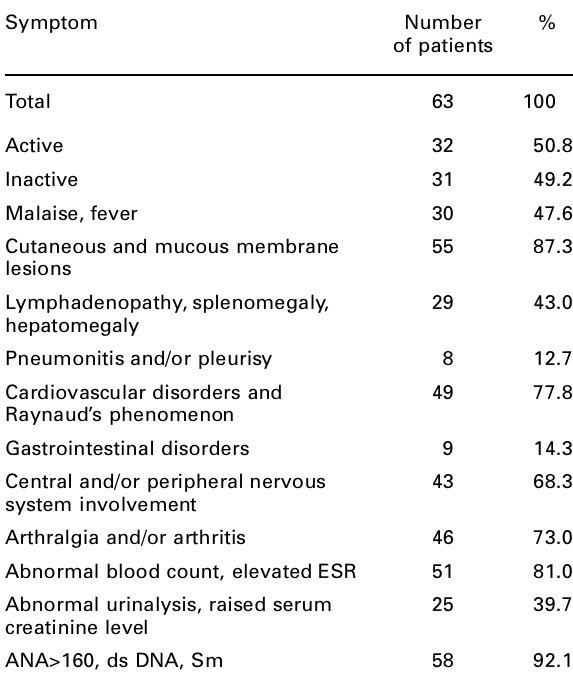
Table 2. Clinical characteristics of 63 patients with